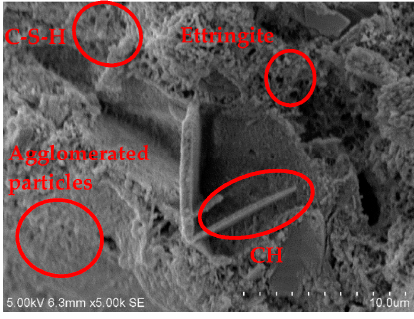
Figure 6. SEM image at 5000× of B40R0 specimen.